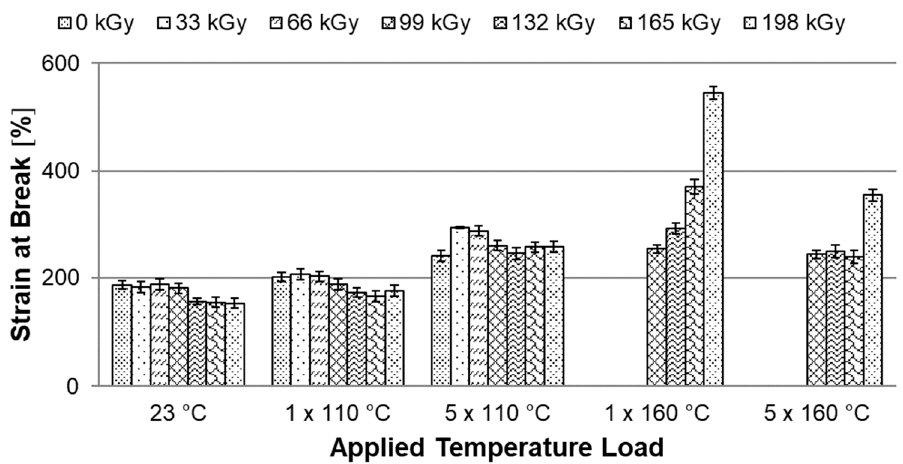
Figure 12. Dependence of the strain at break on applied temperature load.